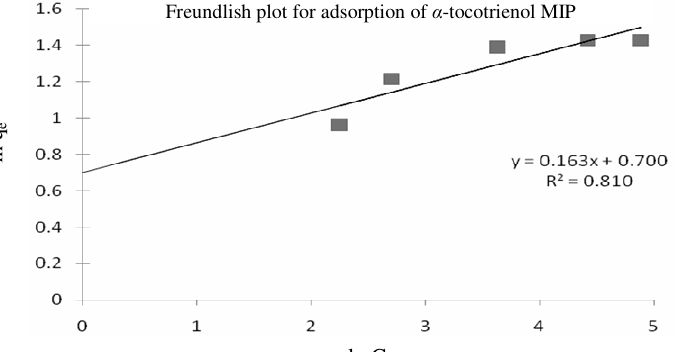
Freundlish plot for adsorption of α -tocotrienol